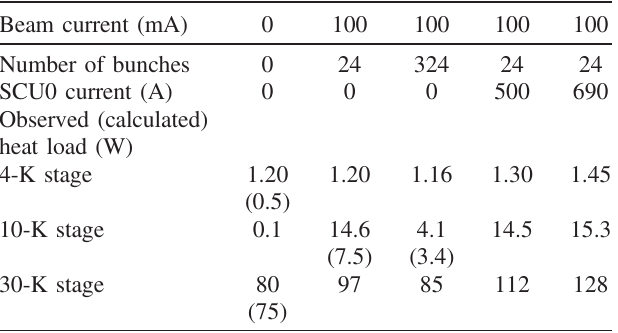
TABLE VII. SCU0 observed and calculated heat loads.